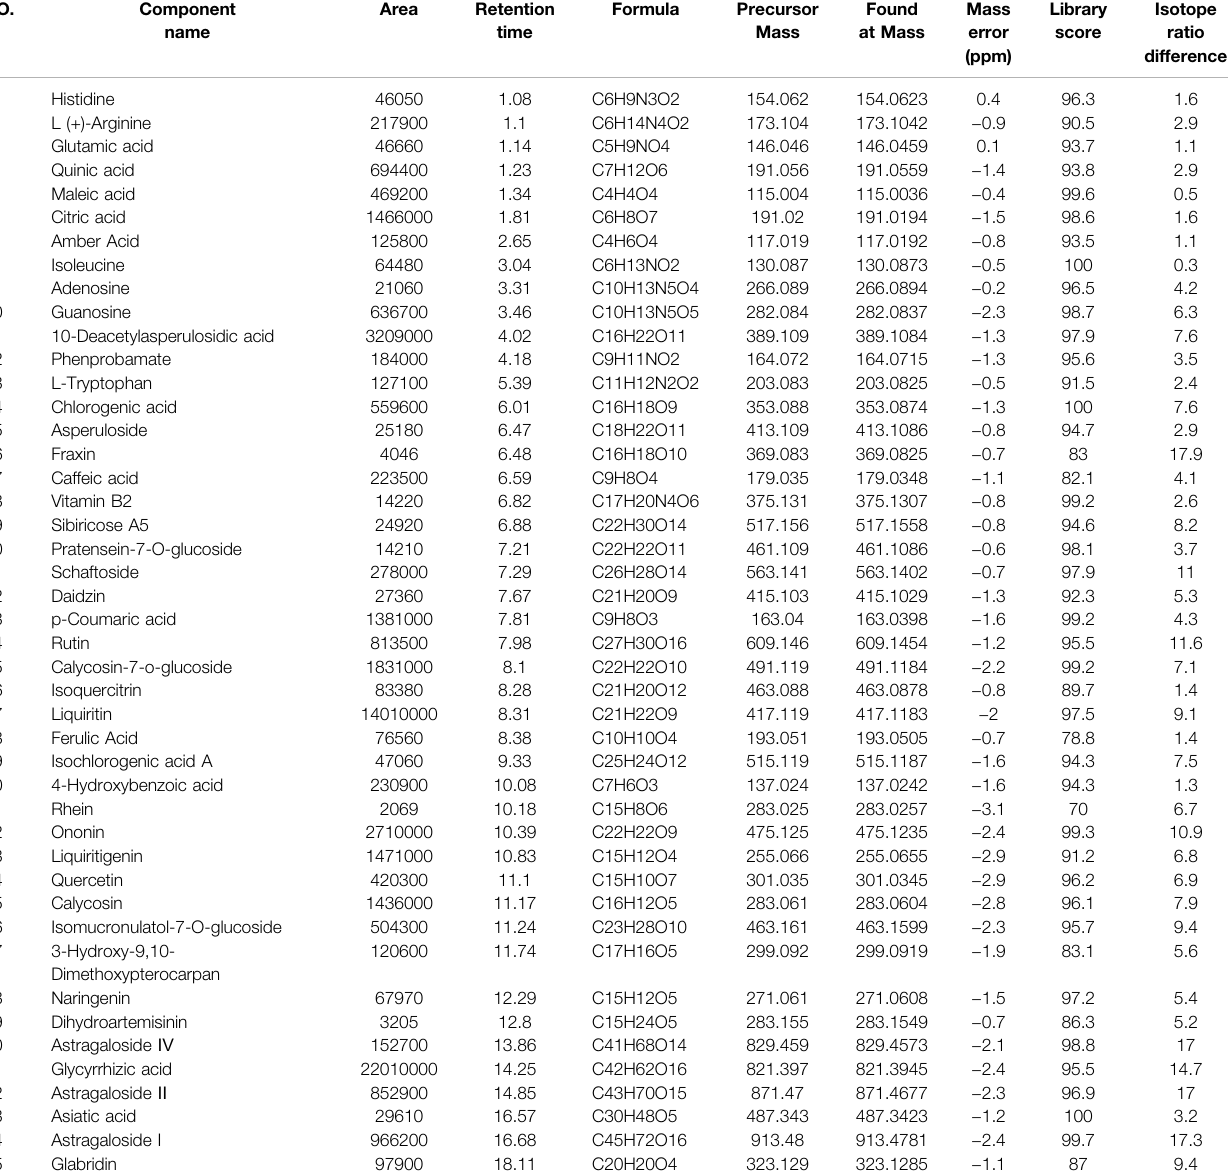
TABLE 2 | Putative identi fi cation of MSJZD in negative ion mode.